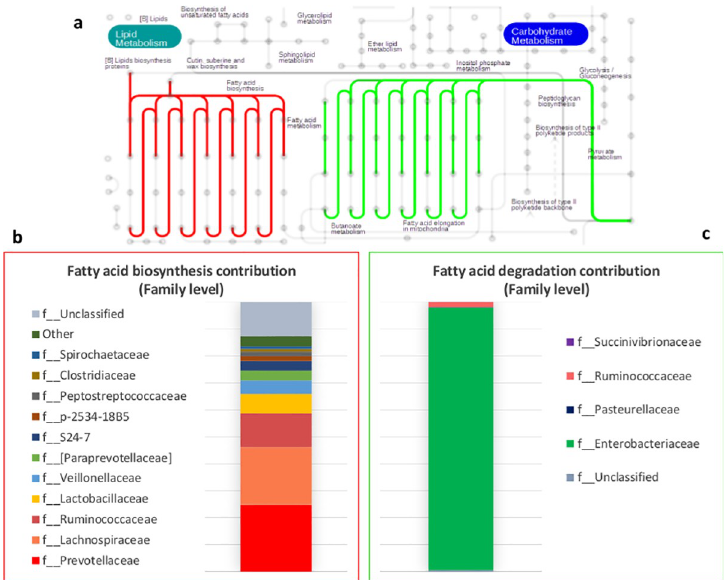
Fig 4. Lipid metabolism in bacterial community of the piglets. Differences between pre-weaning (green lines and square) and post-weaning (red lines and square) and taxonomic contribution at family level. For the complete metabolic map see S13 Fig.